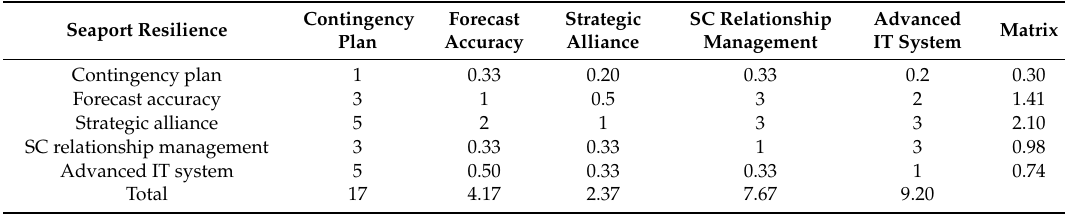
Table 7. Consistency test of port resilience criteria